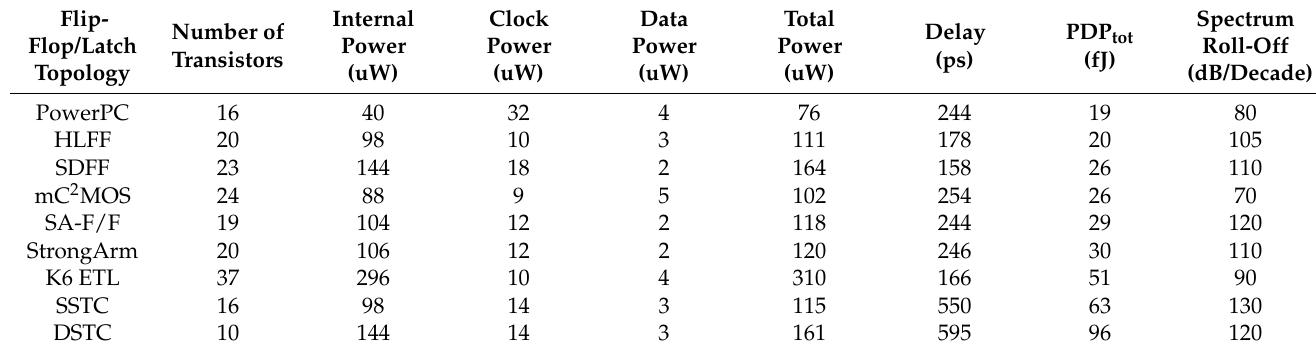
Table 7. Simulation results of the BSIM3 transistor model.